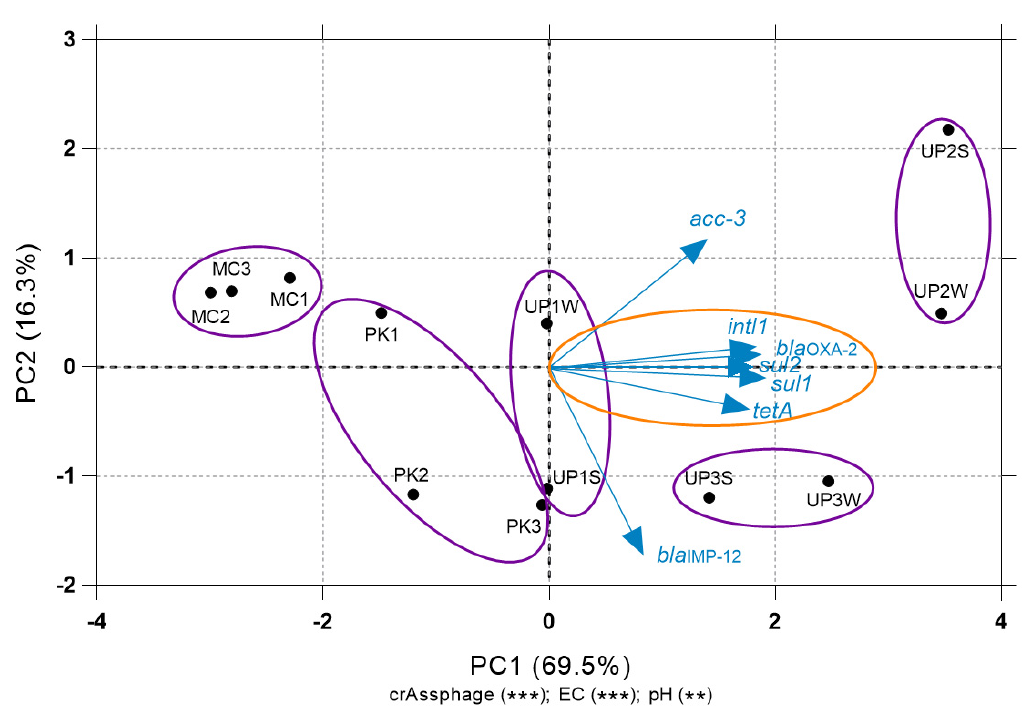
Figure 7. Relationship between environmental variables, intl1 , and ARGs abundance. The PCA was performed with the data of normalized gene abundance per site of ARGs and intl1 . A multiple Lm of the PCs with environmental variables was performed. The numbers in parenthesis represent the percentage of variation explained by the axis, and the parameters that are significantly related to the axis are expressed with: * p < 0.05, ** p < 0.001, and *** p < 0.0001. Related sampling points are indicated within purple circles. The abundance of intl1 and the ARGs are represented as blue arrows. The direction of the arrow indicates an increasing abundance of the genes. The angle of the arrows with respect to the axis represents the linear relation of the abundance with the PC, and the orange circle shows the most important variables ( intl1 , sul1 , sul2 , bla OXA-2 , tetA ). Along the PC1, the abundance of intl1 and ARGs increased toward the right. S: Sediments; W:Water.